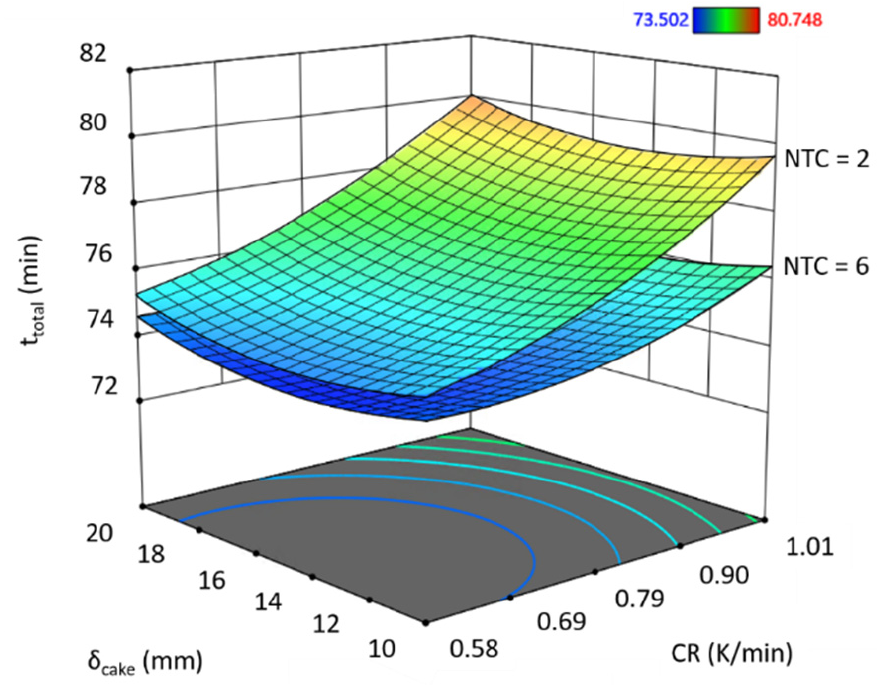
Figure 7. Total drying time ( t total ) as a function of the thickness of the cake ( δ cake ) and the cooling rate (CR) in the scraped surface heat exchanger shown for a low and a high amount of temperature cycles (NTC).